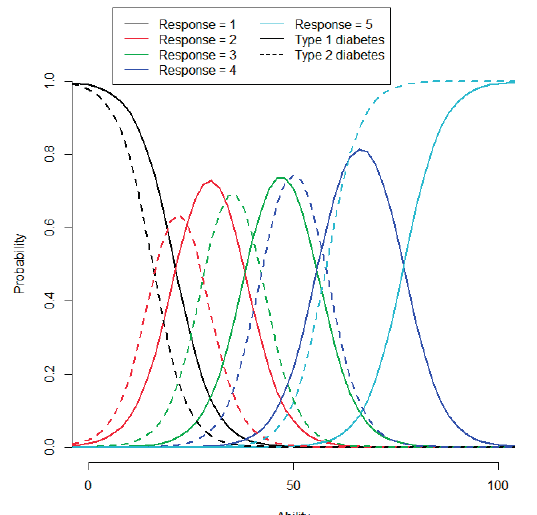
Figure 1. Item response category characteristics curves for item 24 of the Sense of Security scale, by diabetes type. The item is: During the preceding month, how often